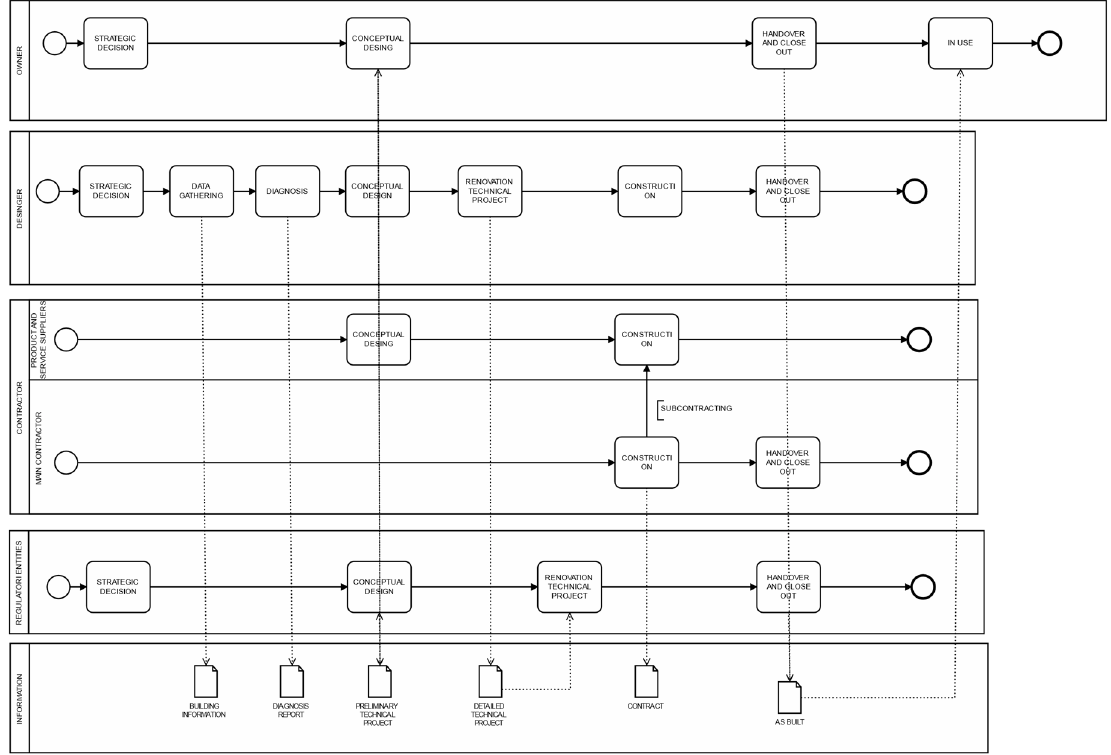
Figure 1. Generic Façade renovation BPMN (Business Process Modelling Notation) diagram